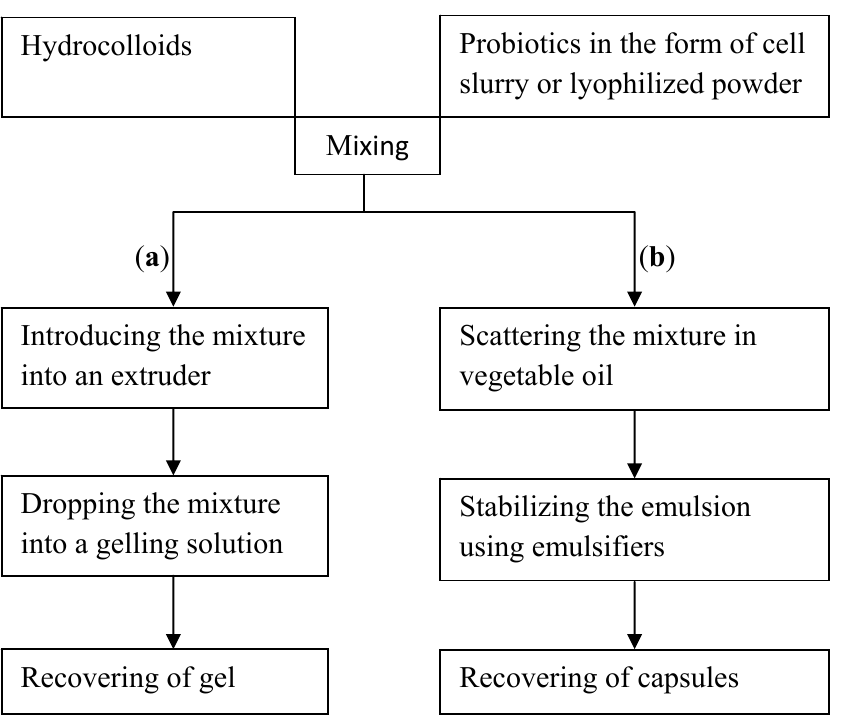
Figure 1. Diagram of the encapsulation process of probiotics by extrusion technique ( a ) and by emulsification technique